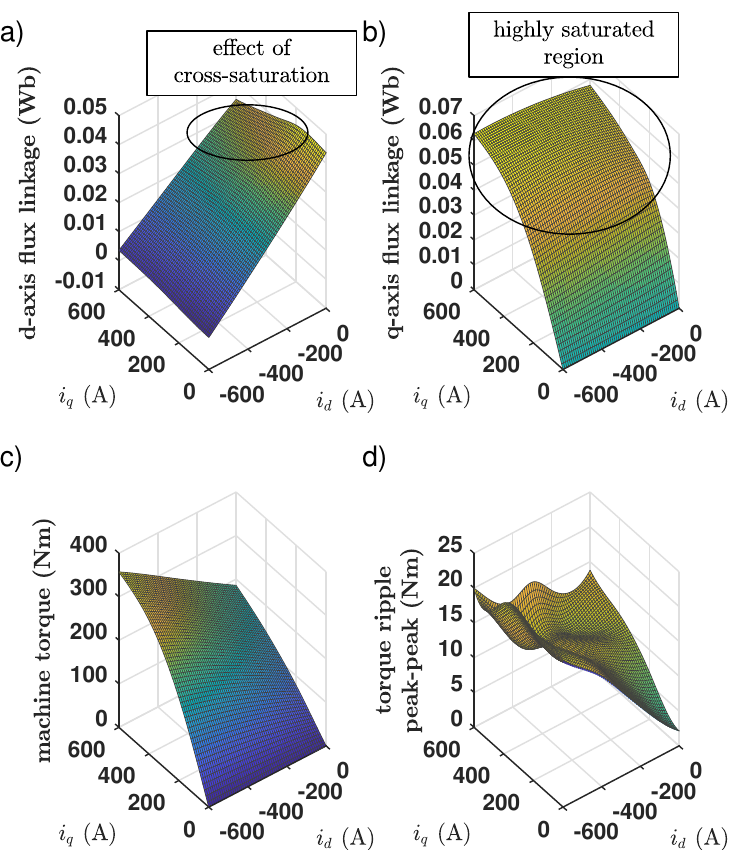
Figure 6. Surface plots of the FEM simulation results for the BMW i3 traction machine: ( a ) d -axis flux linkage averaged over one electrical period, ( b ) q -axis flux linkage averaged over one electrical period, ( c ) torque averaged over one electrical period, ( d ) peak to peak torque